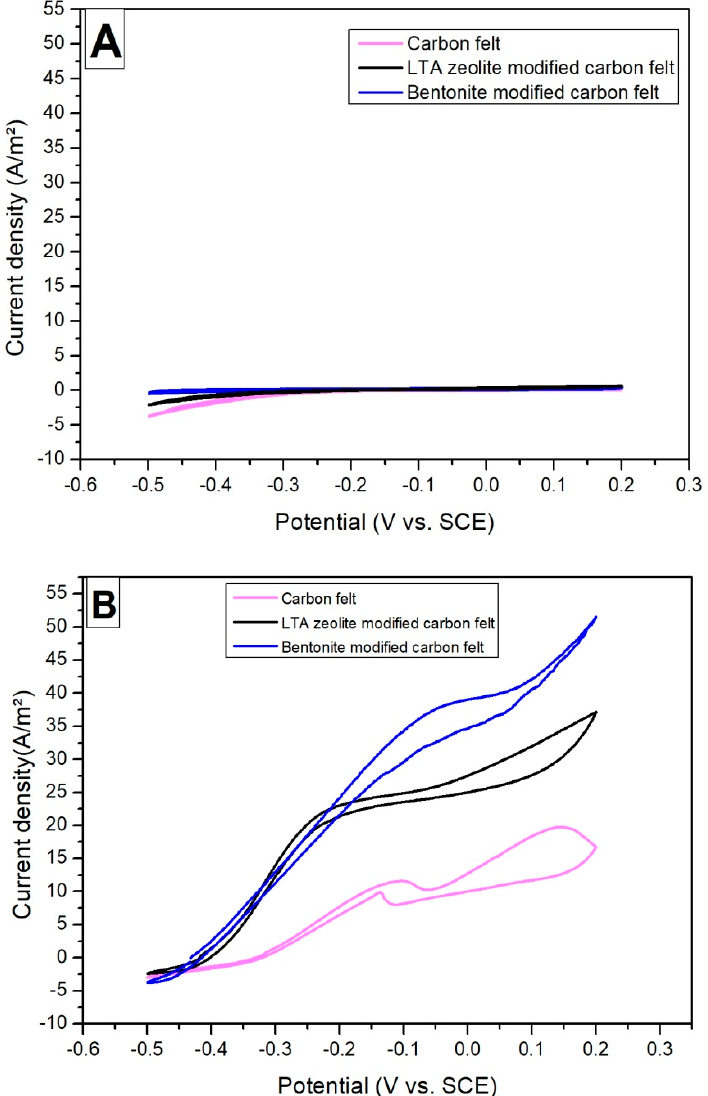
Figure 4. Cyclic voltammetries recorded on untreated carbon felt and modified carbon felt electrodes in tannery wastewater and 20mM of acetate inoculated with acclimated activated sludge. ( A ) At the beginning of the experiment and ( B ) at the maximum current density measured during the chronoamperometry.